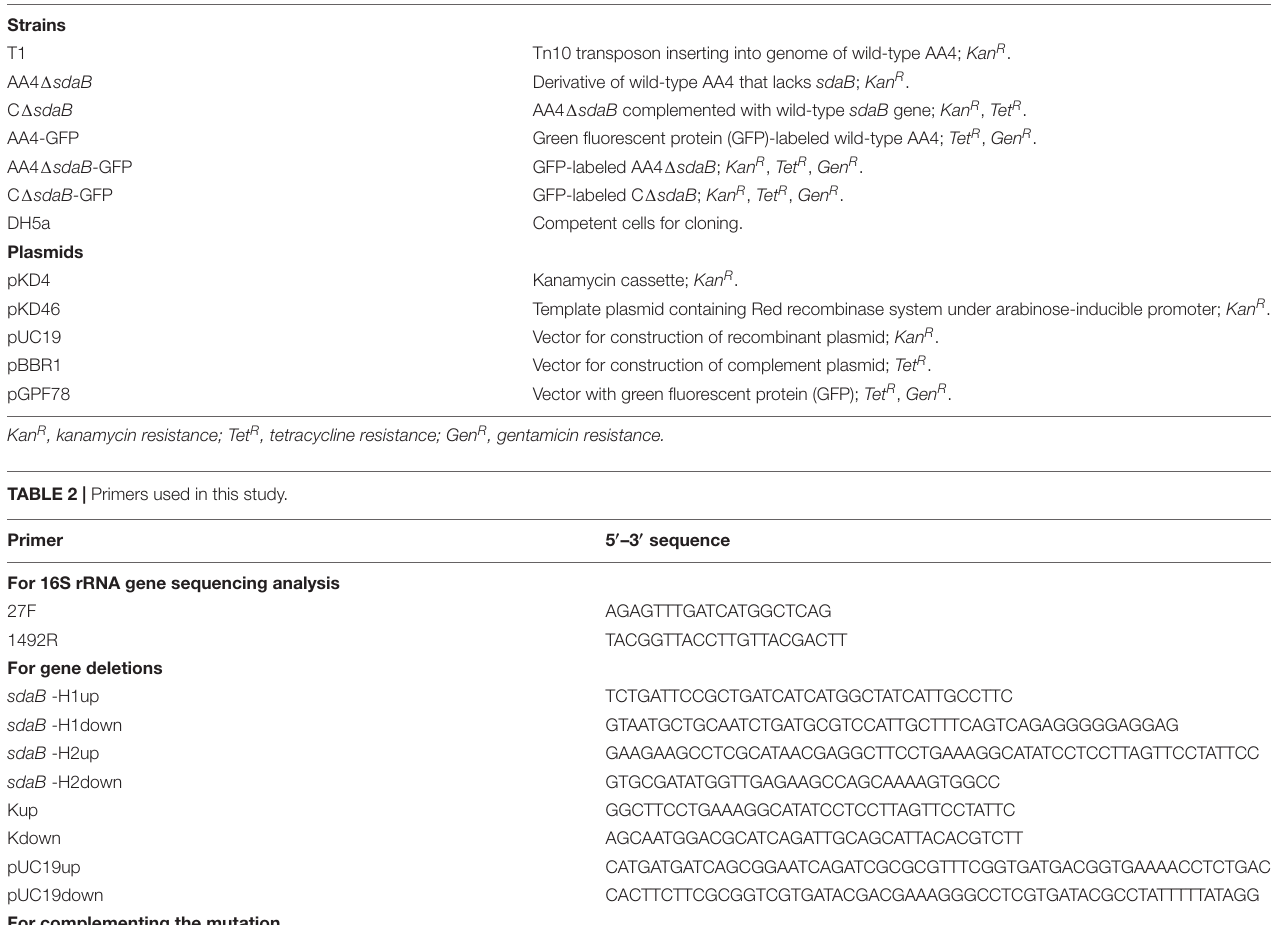
TABLE 1 | Strains and plasmids used for genetic manipulation of Enterobacter ludwigii AA4. Strain or plasmid Description